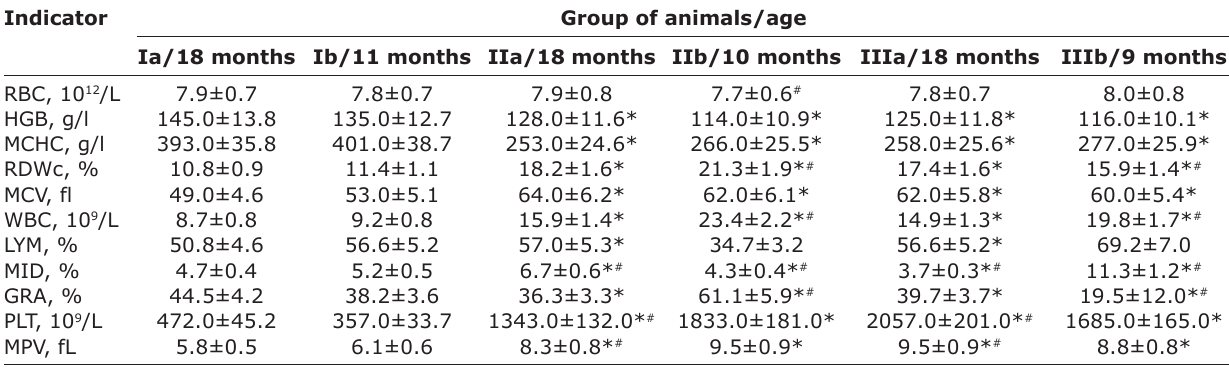
Table-4: Hematological parameters of rats (experiment of 12 months). Indicator